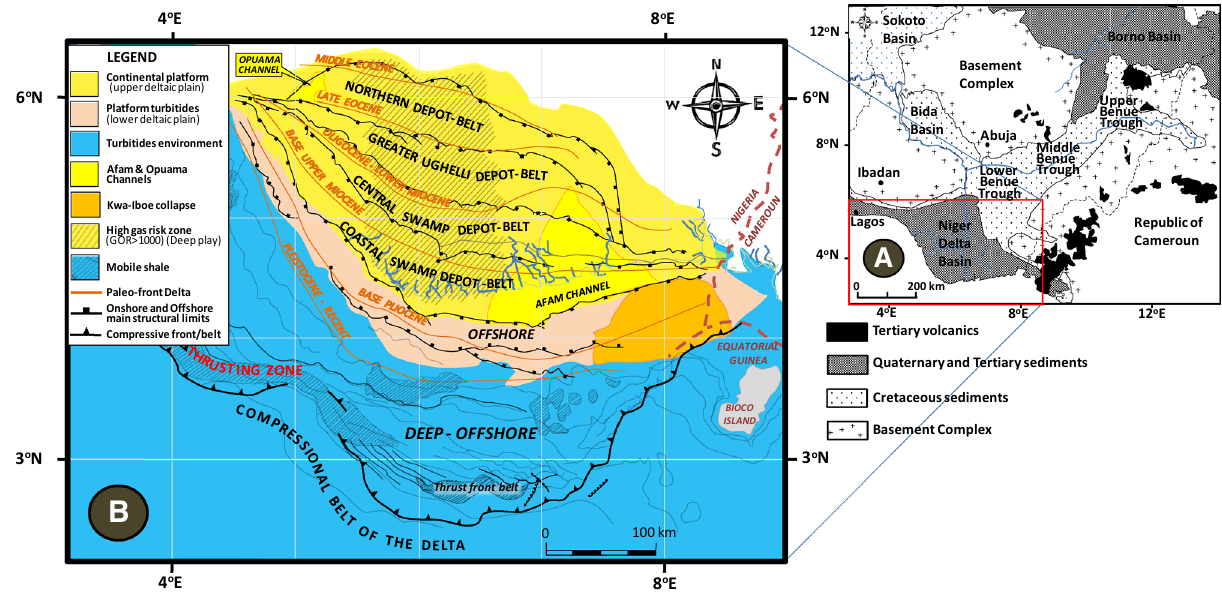
Fig. 1 Geologic map of Nigeria showing the location of the Niger Delta Basin ( a ) (redrawn from Ebong et al. 2017) and sectional map of the Niger Delta depobelts and structural limits ( b ) (Redrawn from Doust and Omatsola